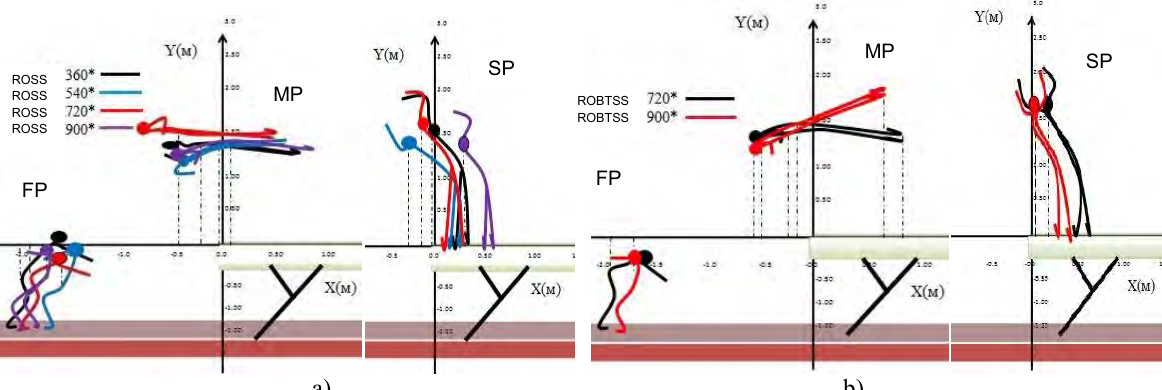
Fig.1. Key elements of dismounts from BB, fulfilled by junior, 12-14 years old female gymnasts, finalists of championship in Rumania, in exercises on